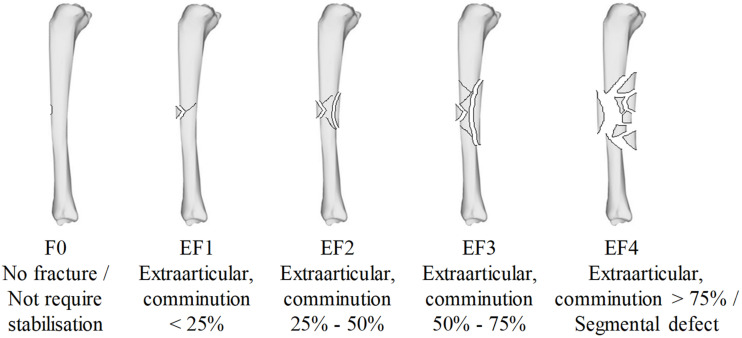
The modified Winquist-Hansen fracture classification applied to the tibia impacted by a small metallic fragment-simulating projectile; adapted from Memarzadeh et al. (2017).